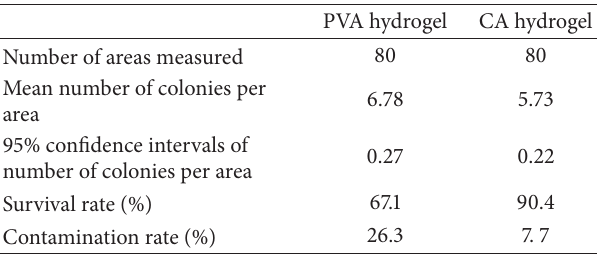
Table 2: Survival rate of E. coli on PVA and CA hydrogel media after 24